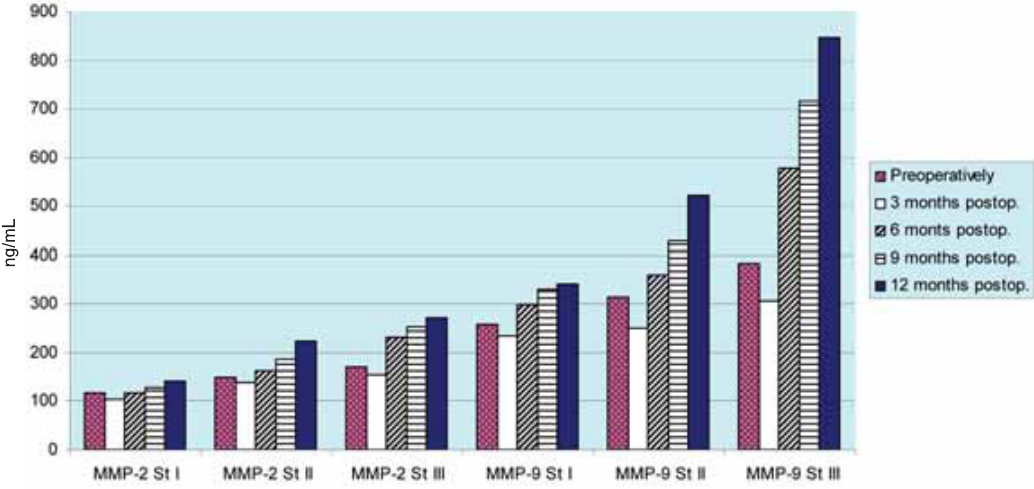
FIGURE 1. Mean MMP-2 and MMP-9 (ng/mL) serum values in terms of disease staging and defi ned points of time